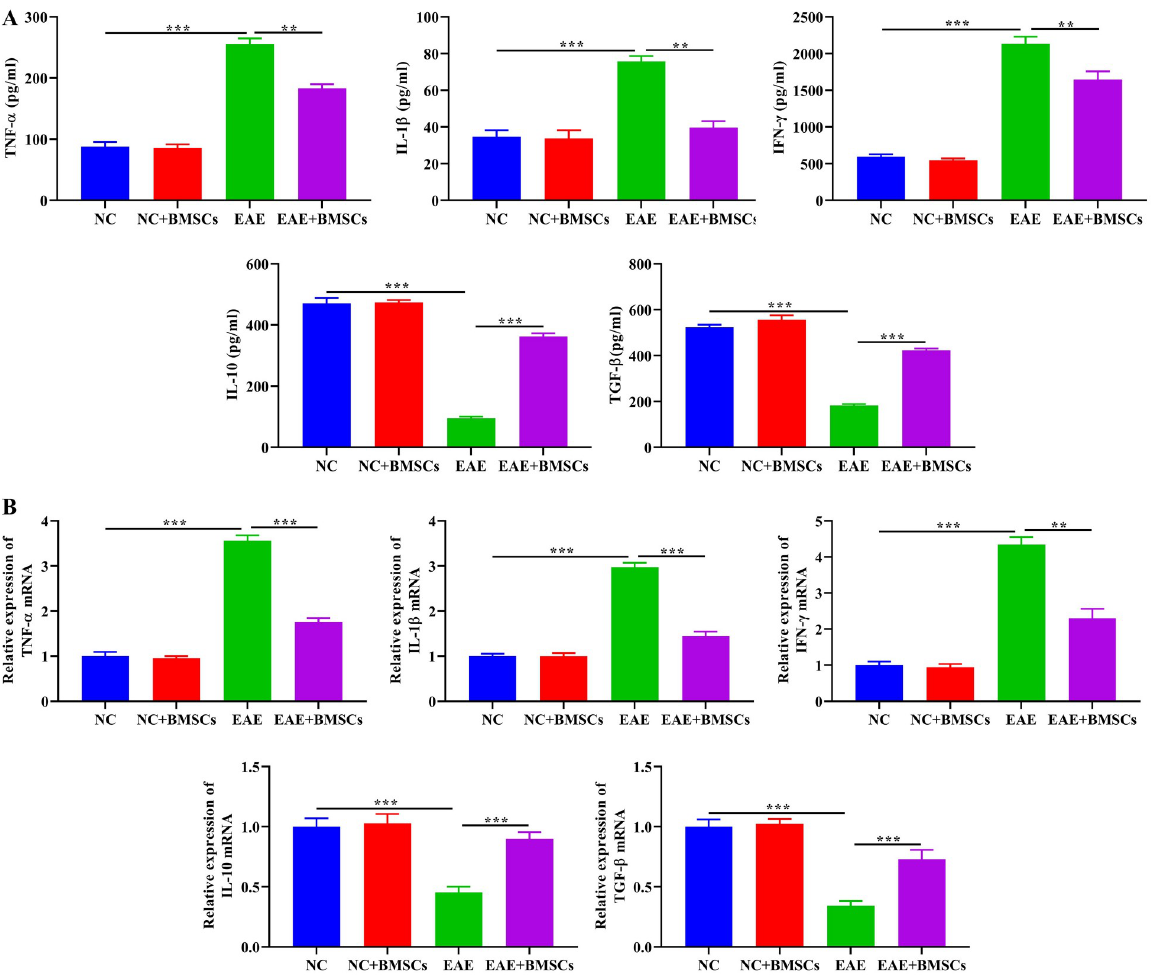
Fig 5. Effect of BMSCs transplantation on inflammatory factor expression during EAE progression in mice. On the 16th day post- immunization, (A) ELISA was performed to detected the levels of pro-inflammatory factors (TNF- α , IL-1 β and IFN- γ ) and anti-inflammatory factors (IL-10 and TGF- β ) of mice serum of each group. (B) RT-qPCR indicated the expression of TNF- α , IL-1 β , IFN- γ , IL-10 and TGF- β mRNA of mice spinal cord of each group. In all cases, Values are mean ± SD (n = 15 for each group; �� P < 0.01, ��� P < 0.001).